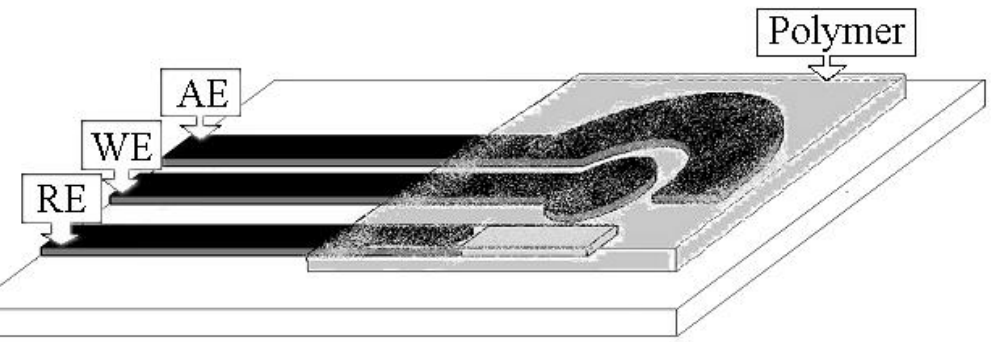
Figure 2. Schematic view of screen-printed cell modified by a polymeric layer, either MIP (SPC-MIP) or NIP (SPC-NIP). WE: working electrode (graphite ink); AE: auxiliary electrode (graphite ink); RE: reference electrode (silver ink).